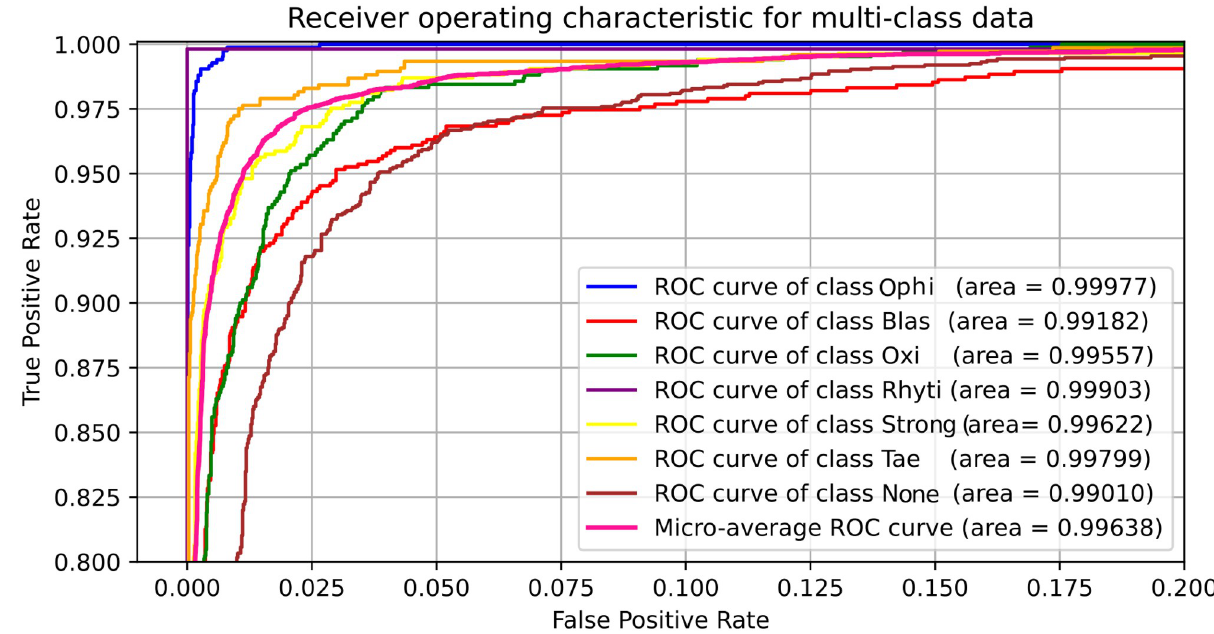
Fig 10. ROC plot for the MobileNet model.